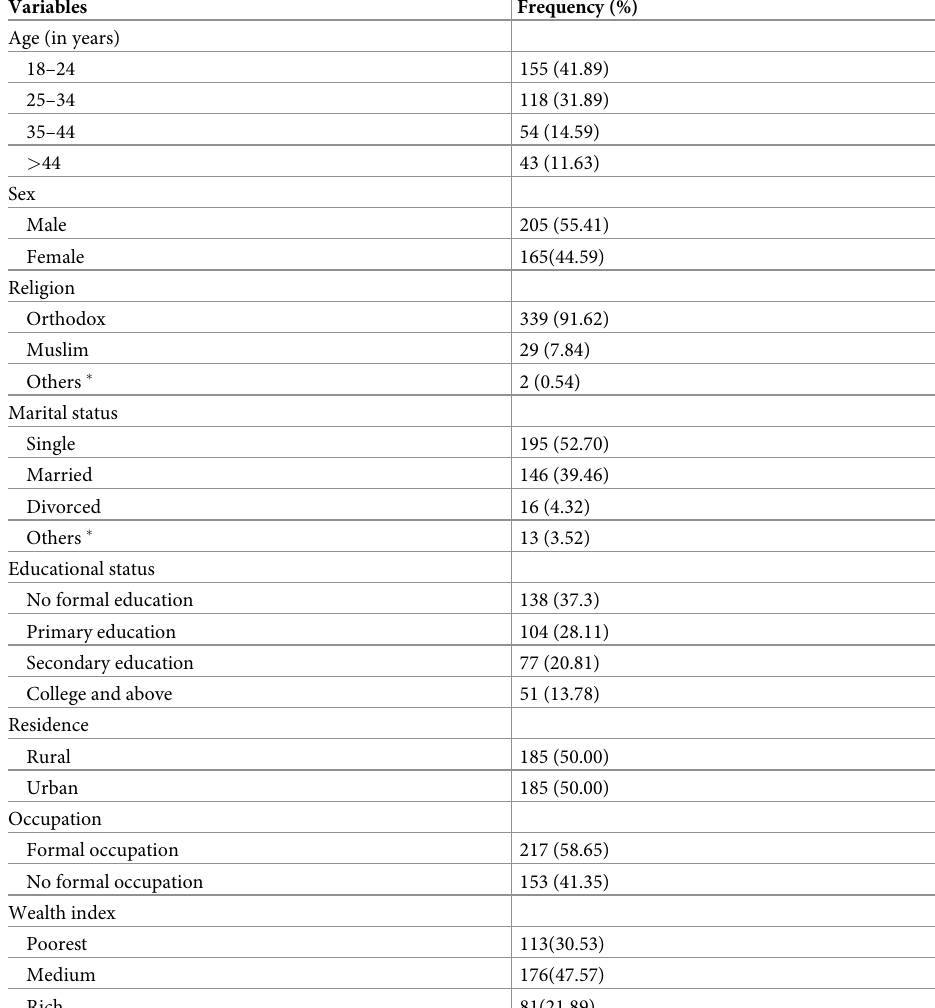
Table 1. Socio-demographic characteristic of the study participants (n = 370) in Gondar Specialized Hospital, Gondar town, northwest Ethiopia,